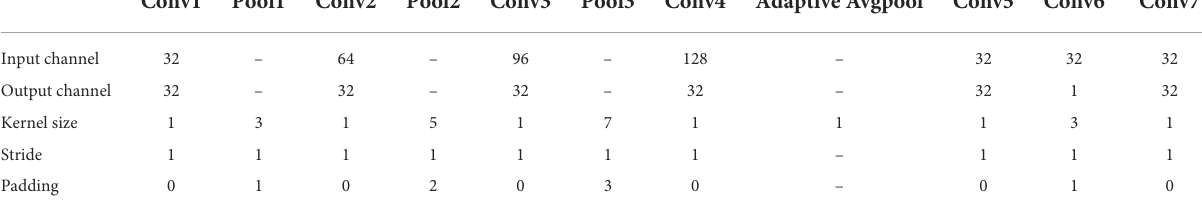
TABLE 1 The parameter settings of the proposed AGFEB.